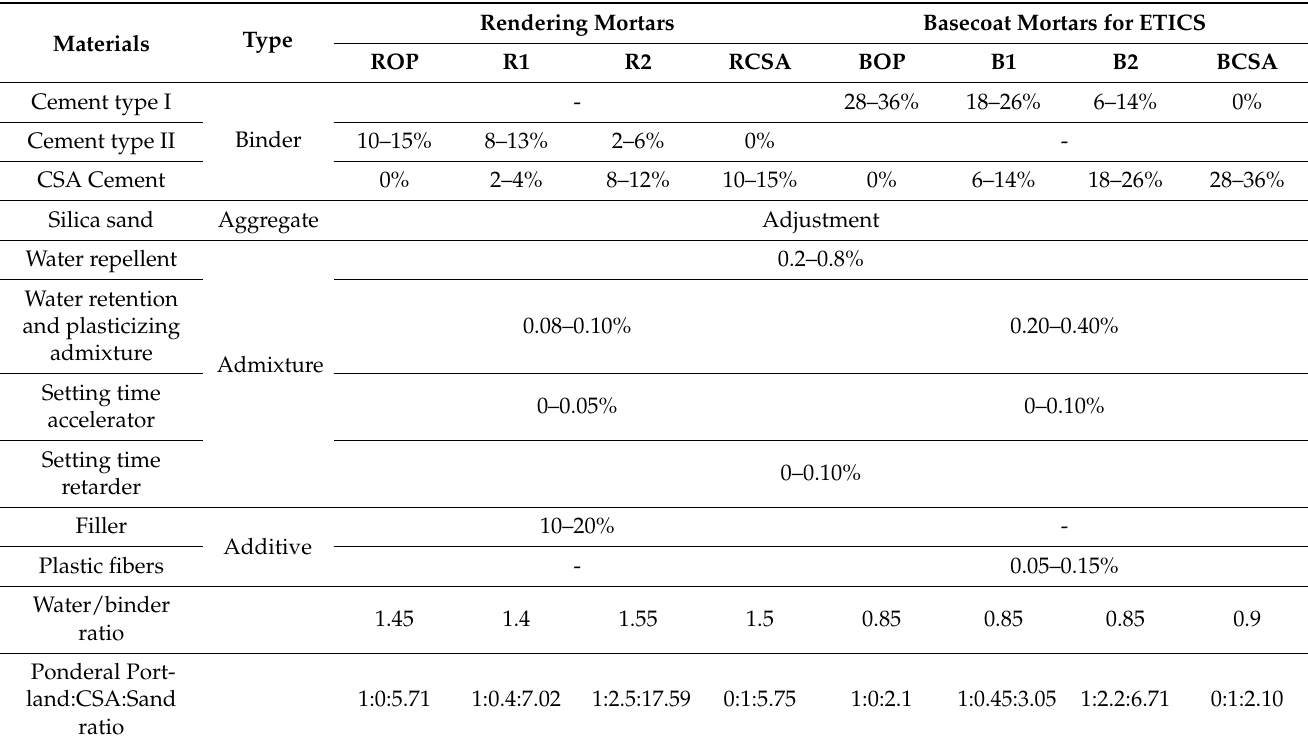
Table 3. Composition of the mortar mixtures (% in mass).